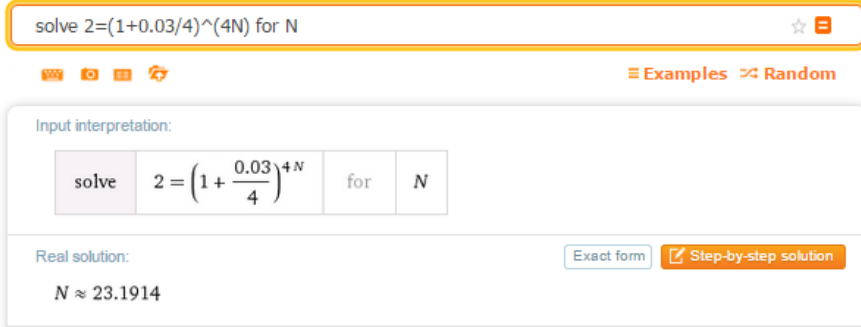
Fig. 3. Calculation of number of years by solving